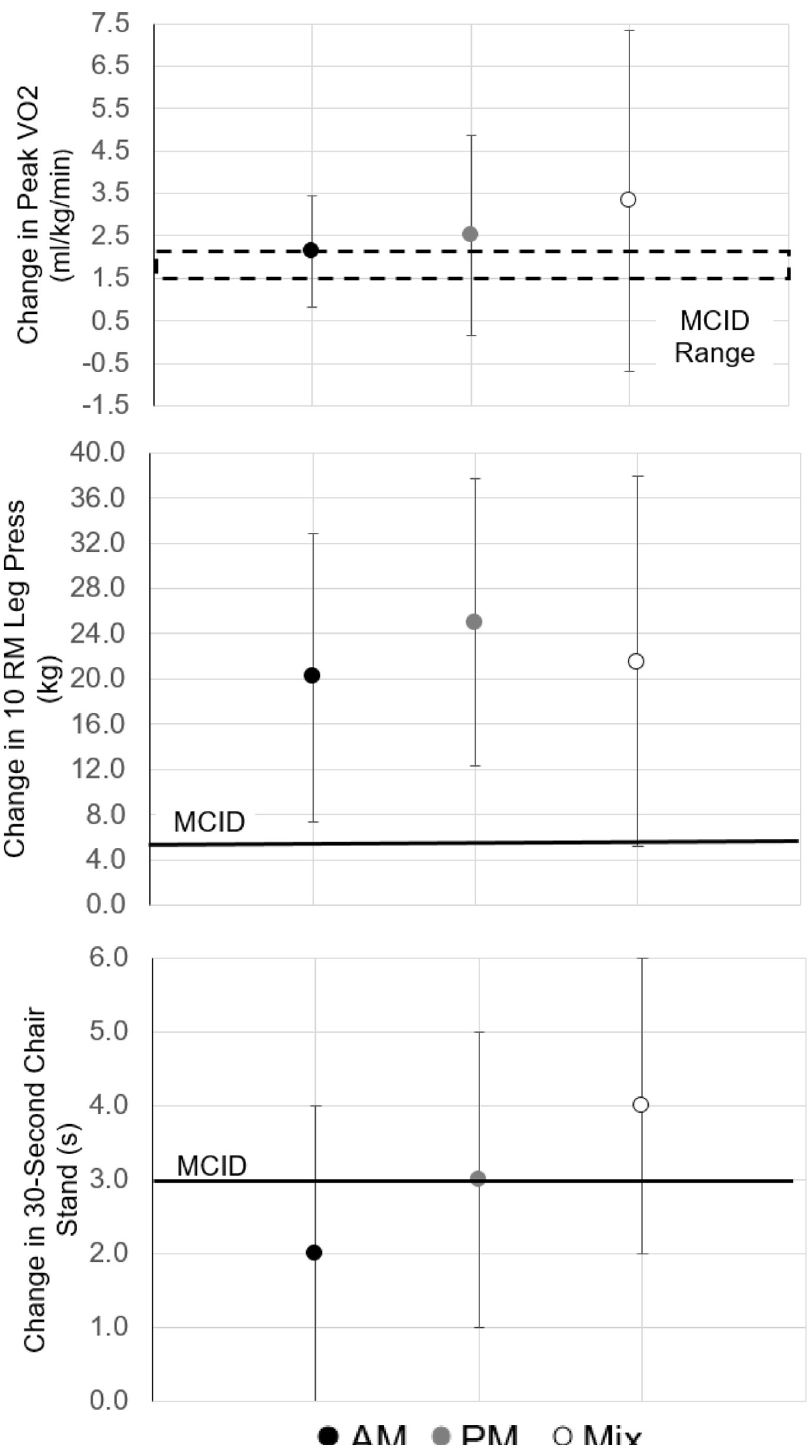
Fig 2. Statisticially significant changes in health outcomes that exceeded the minimal clinically important difference (MCID) threshold among breast cancer survivors. Data presented as mean and 95% confidence intervals.